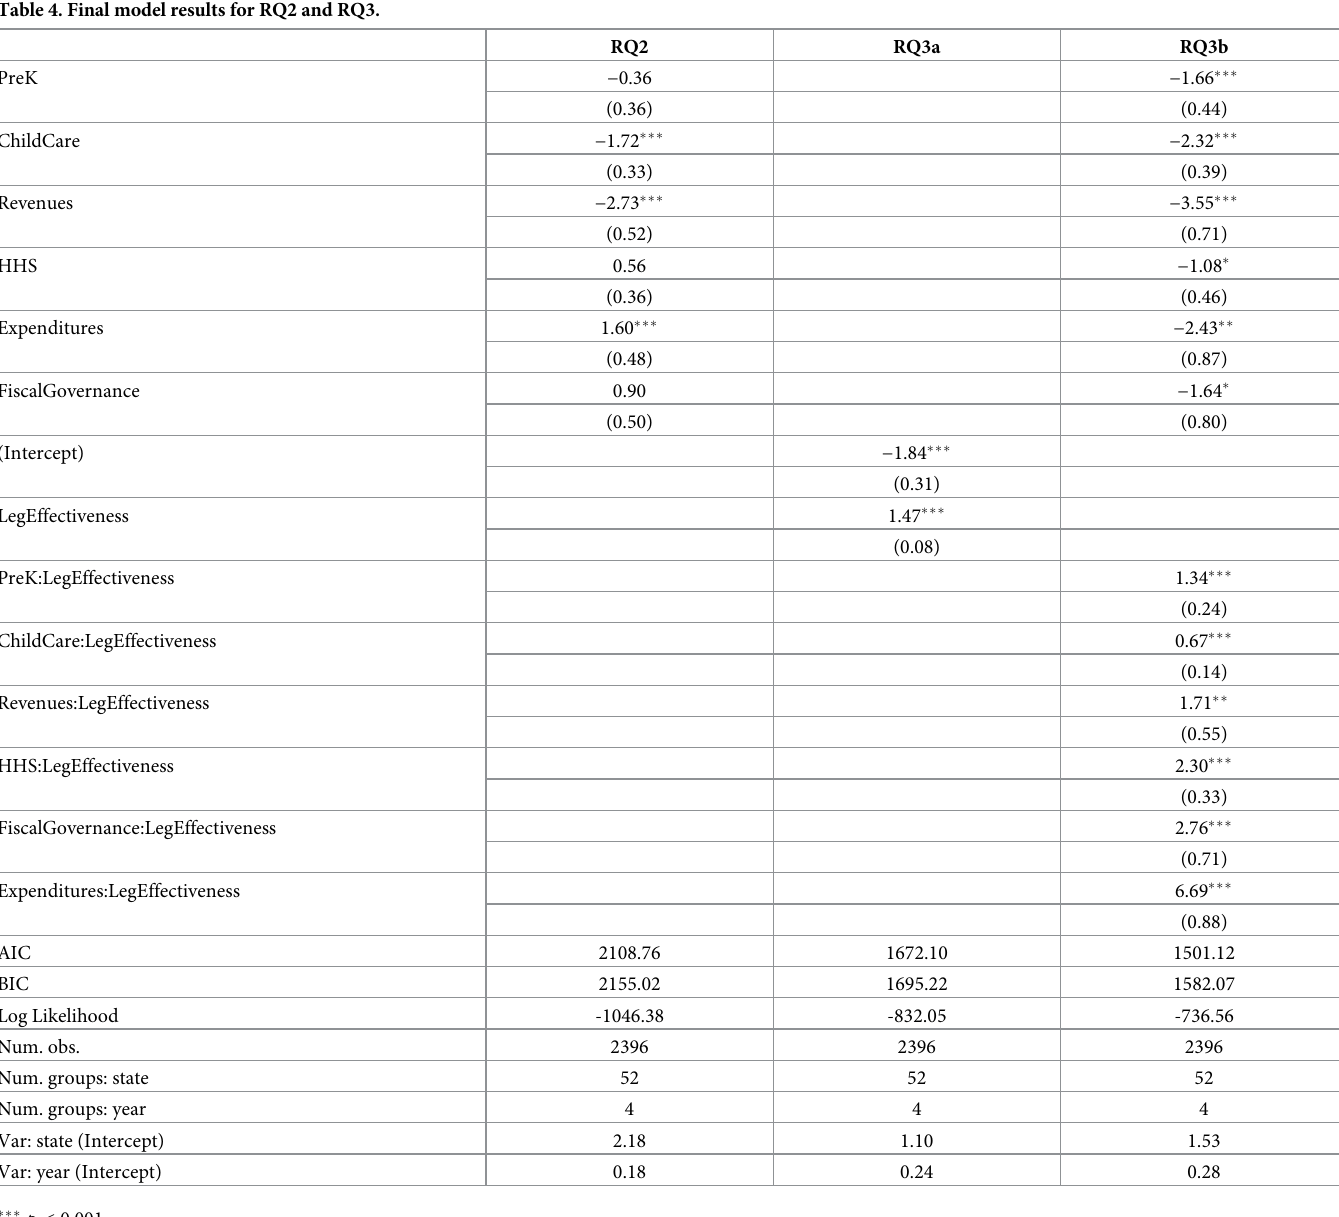
Table 4. Final model results for RQ2 and